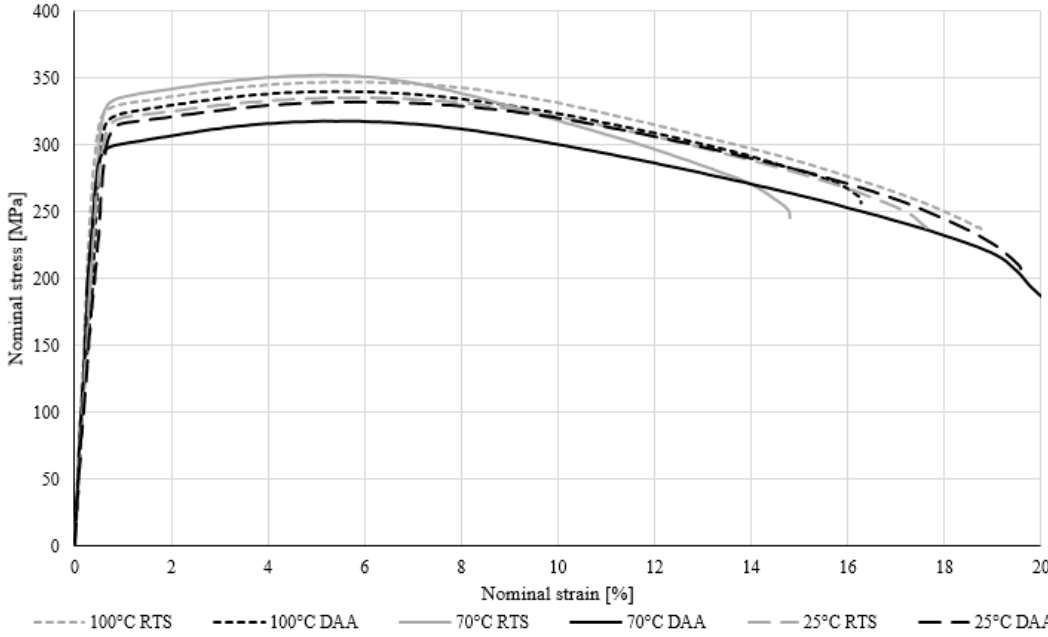
Figure 6. Stress–strain curves for samples being quench interrupted at different temperatures before room temperature storage (RTS) and direct artificial aging (DAA).